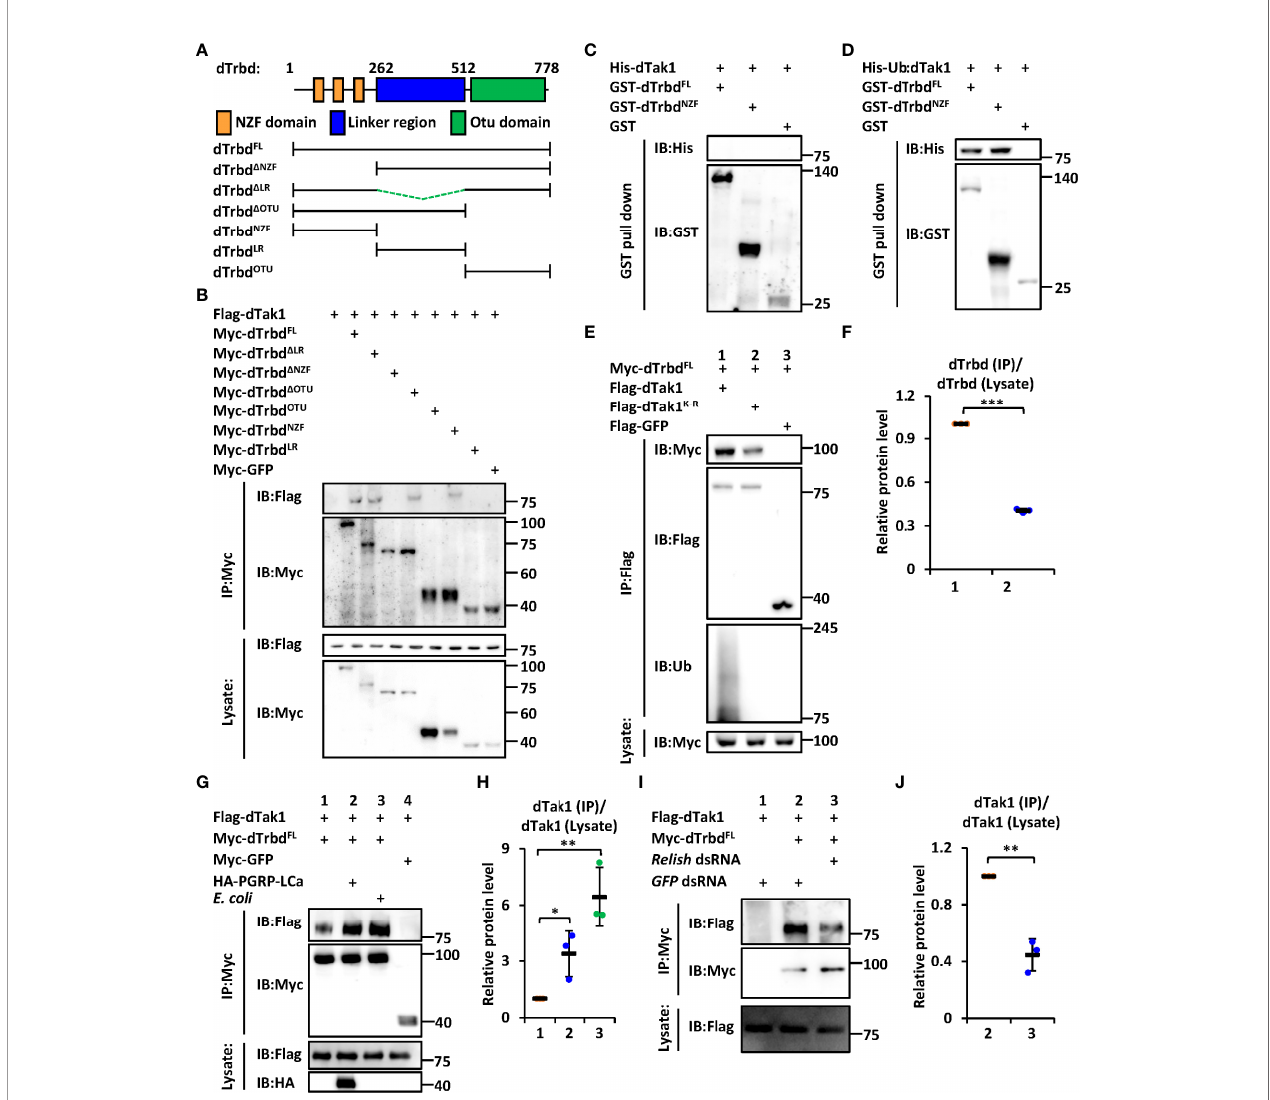
FIGURE 1 | dTrbd associates with dTak1 via the N-terminal NZF domain. (A) Domain architecture of dTrbd. (B) Various combinations of expressing plasmids were transfected into S2 cells as indicated. 48 h post transfection, cells were lysed for immunoprecipitation assays using anti-Myc agarose beads, followed by